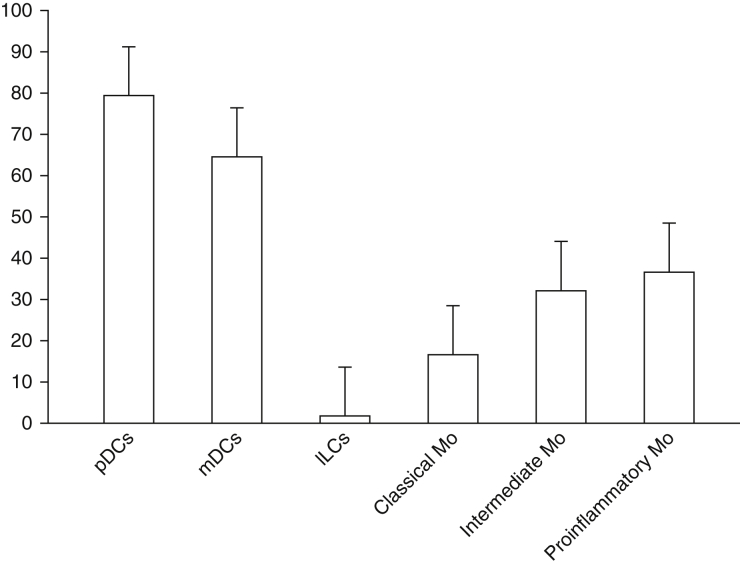
IL-36 receptor surface expression measured as mean fluorescence intensity. Data are presented as the mean (± SEM) of measurements obtained in three unrelated healthy donors. ILC, innate lymphoid cell; Mo, monocyte; SEM, standard error of the mean.